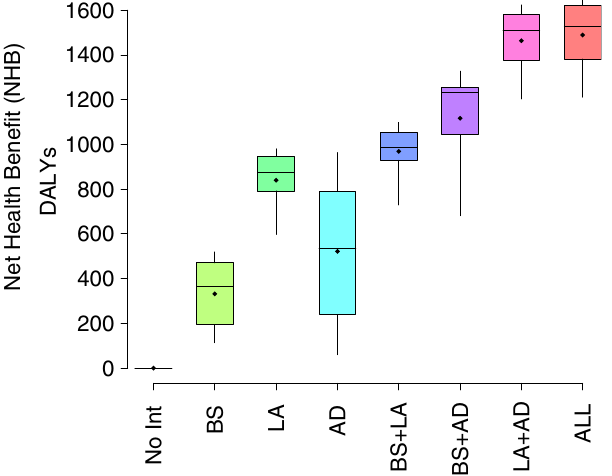
Figure 1. Posterior distribution of the Net Health Benefit (NHB) for each intervention strategy considered 12 versus the hypothetical scenario where no intervention is implemented, under the assumption that the willingness to pay for the healthcare system is €30000. Intervention strategies associated with positive values of the NHB should be considered as cost-effective. BS refers to breeding sites removal, LA to larvicides and AD to adulticides, while No Int refers to the scenario without any intervention.